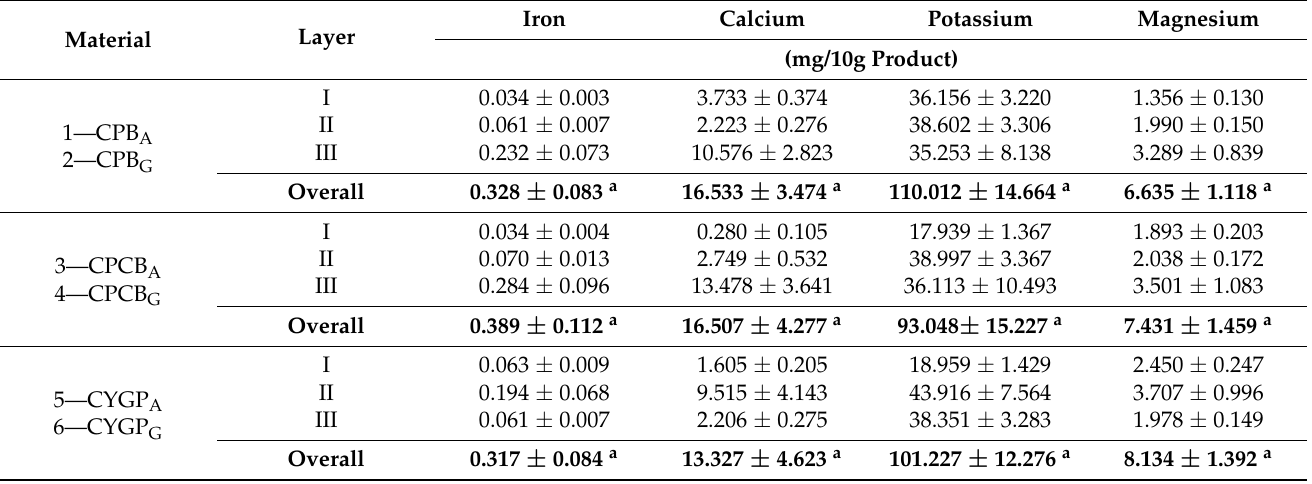
Table 3. Average content of selected minerals (pro-health value) in freeze-dried products formed on the basis of vegetables produced with